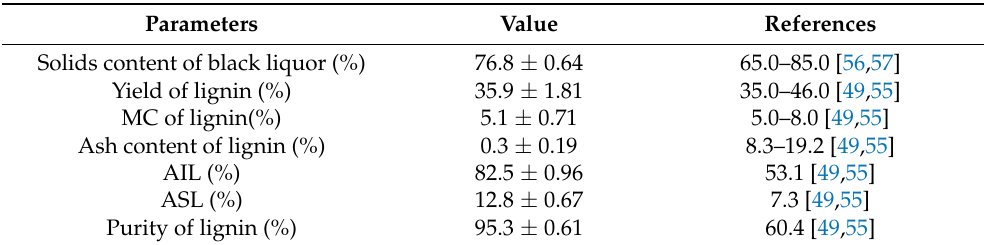
Table 3. Properties of lignin from black liquor. Parameters